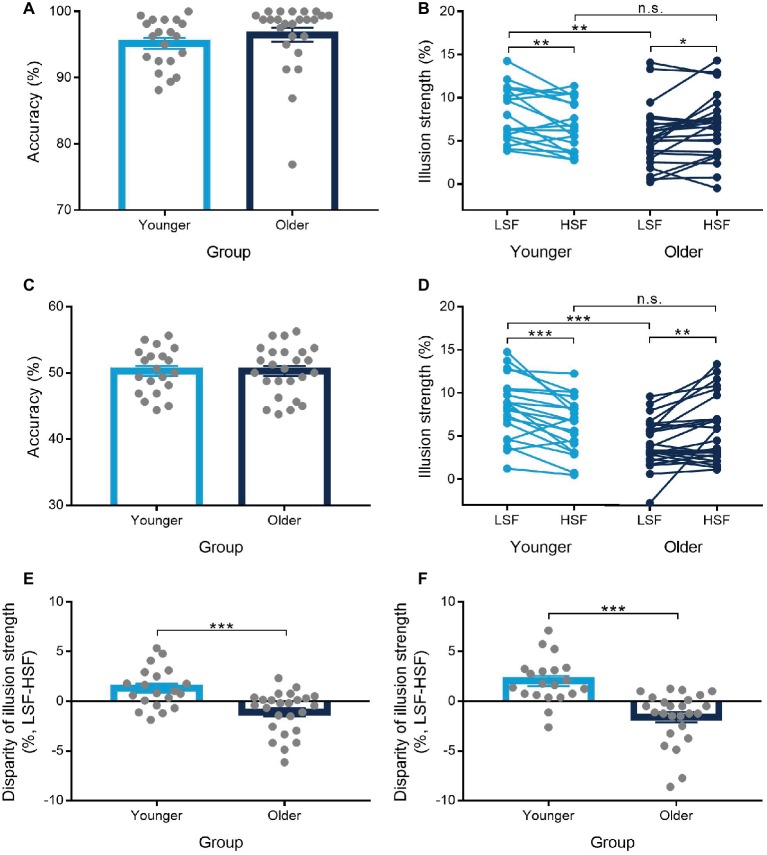
Results from Experiments 1 and 2. Accuracy of gender discrimination task during the test phase in Experiments 1 (A) and 2 (C), the illusion strength as a function of low-spatial-frequency (LSF) and high-spatial-frequency (HSF) conditions in Experiments 1 (B) and 2 (D), and the disparity of illusion strength between the LSF and HSF conditions in Experiments 1 (E) and 2 (F). Error bars represent one standard error of the mean. Asterisks (*) indicate significance level of *p < 0.05, **p < 0.01, and ***p < 0.001.